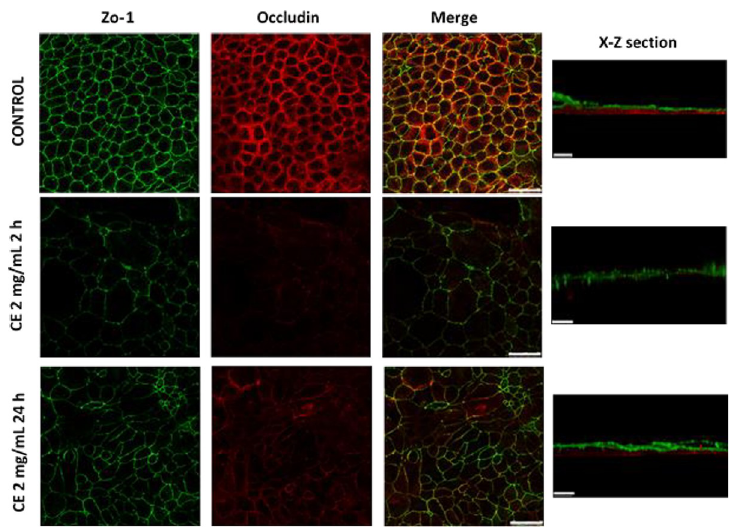
Fig 8. Effects of A . simplex CE on TJ proteins. Caco-2 cells were incubated with medium or 2mg/mL CE and, thereafter, immunofluorescence staining was performed to localize ZO-1 (green) and occludin (red). TJ proteins distribution is shown at the time of maximal decrease of TEER (2 hours) and recovery of TEER (24 hours). Scale bar represents 50 μ m (x-y section) or 20 μ m (x-z section).